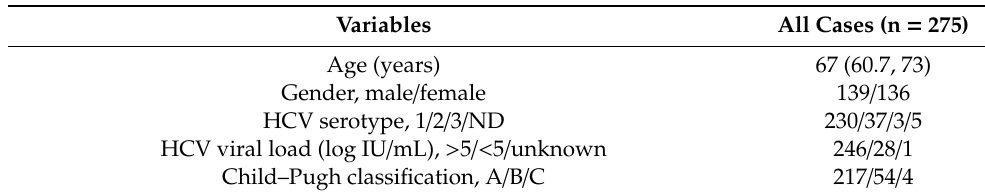
Table 1. Baseline characteristics (n =